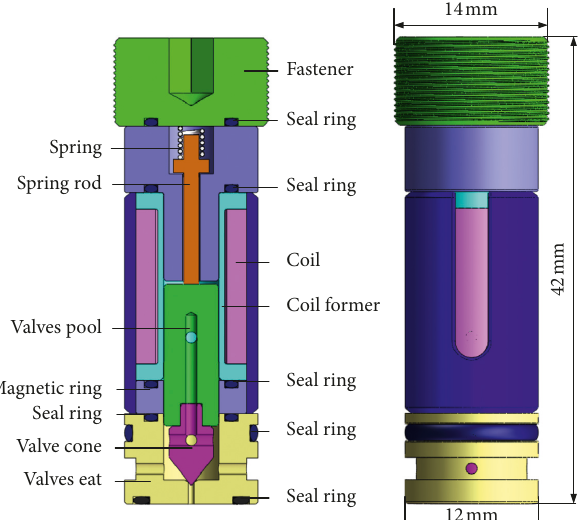
Figure 1: Novel micro high-speed digital valve.